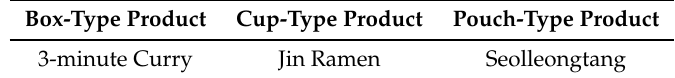
Table 1. Target products used for the experiments.